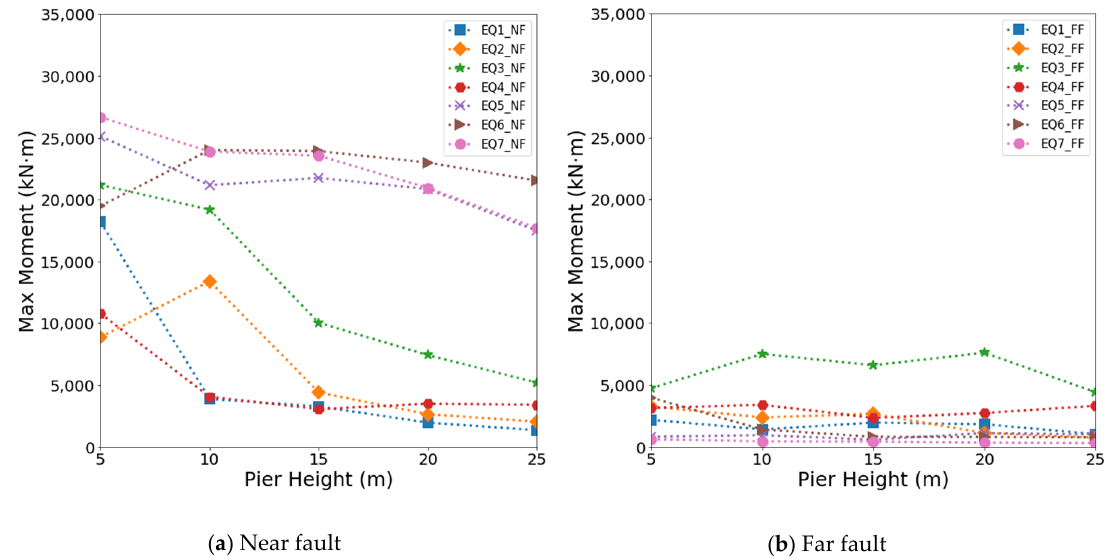
Figure 13. Maximum moment with increasing bridge height: ( a ) Maximum moment under near-fault ground motion; ( b ) Maximum moment under far-fault ground motion.